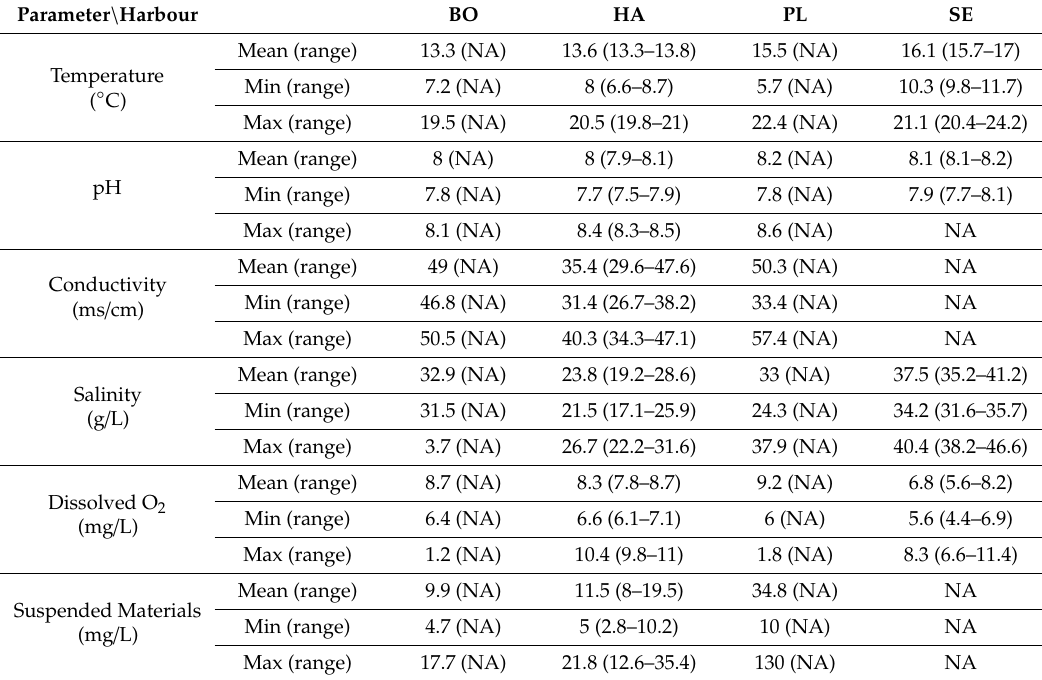
Table A1. Mean values and ranges (in brackets) of some the physico-chemical parameters of seawater near the studied structures in the immersed